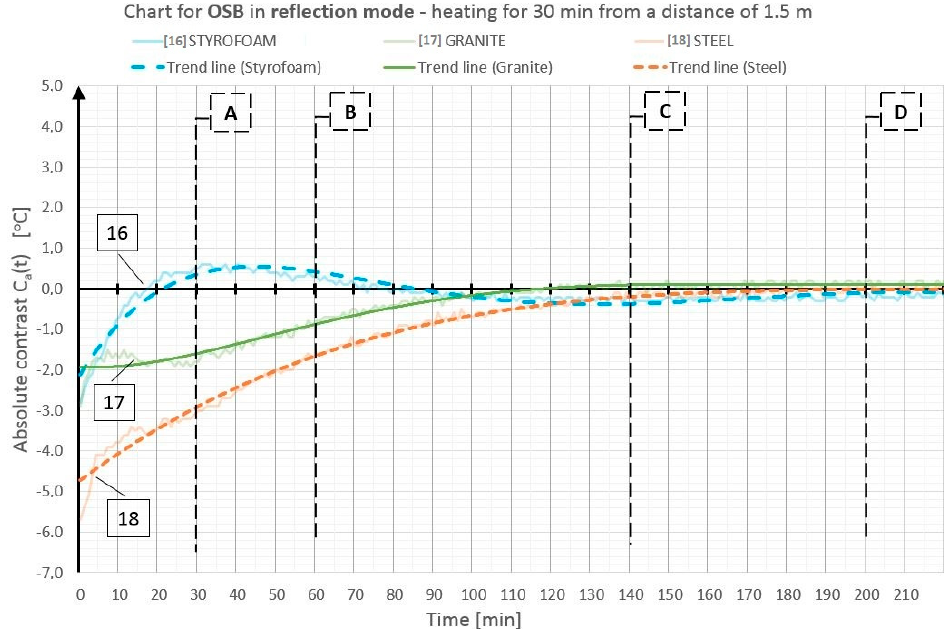
Figure 9. Diagram of absolute contrast for measuring in a reflection mode for the OSB partition model with heating from a distance of 1.5 m (based on thermograms in Figure 3, row VI).